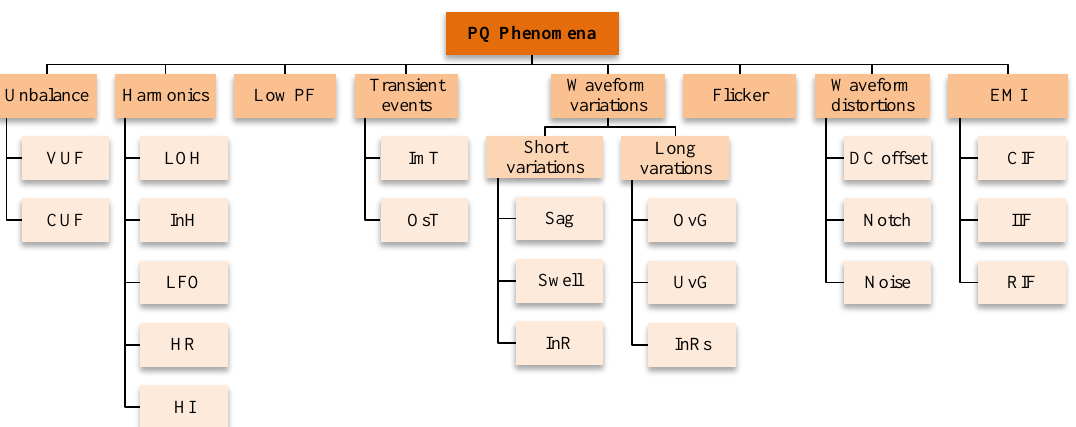
Figure 26. Classification and organization chart of power quality (PQ) phenomena in ERPS.